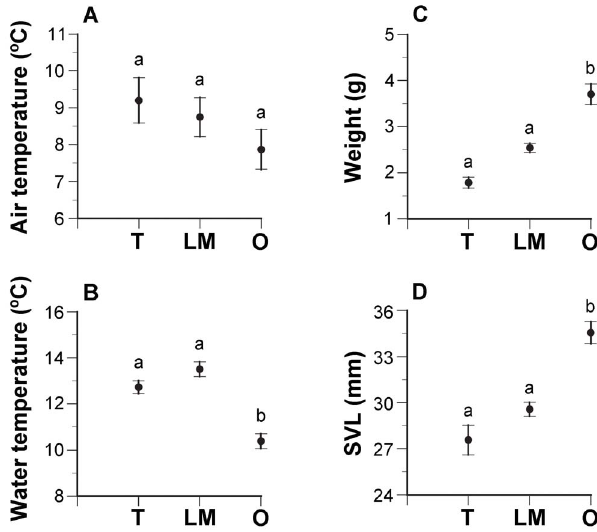
Figure 3. Environmental and body variables measured for recorded subjects from the three populations studied. A: air temperature B: water temperature, and C: body weight, B: snout-vent length. Filled circles and bars represent averages and standard errors, respectively. Different lowercase letters indicate significant differences among populations. Abbreviations: T: Totoral, LM: Los Maitenes, O: Osorno. doi:10.1371/journal.pone.0087732.g003 PLOS ONE |